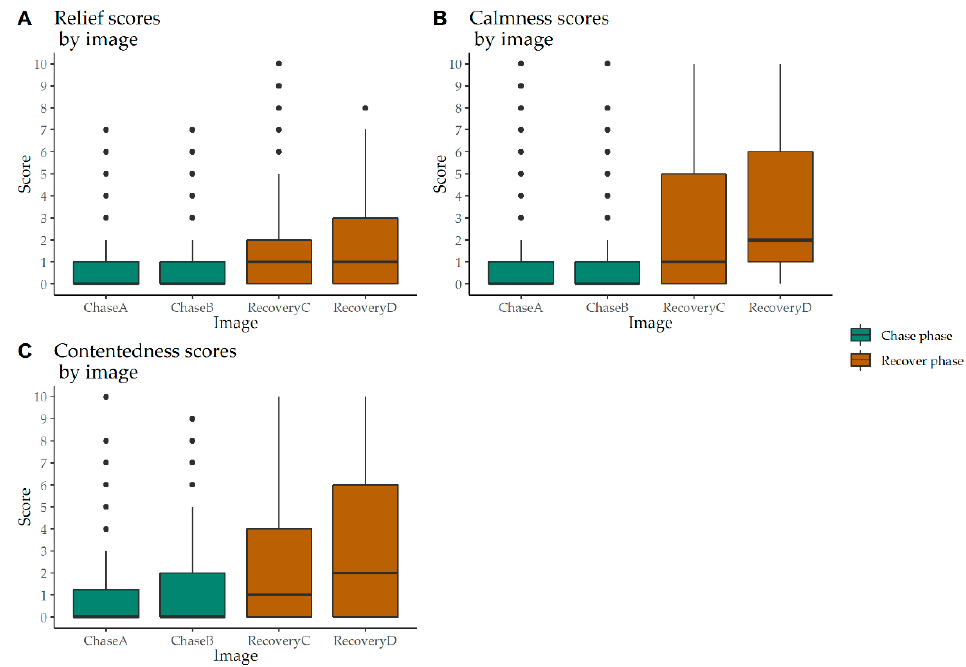
Figure 5. Box and whisker plot of relieved, calm and contented scores applied by a panel of 16 students on 80 images of calves ( n = 20) showing higher scores in the recovery phase compared to the chase phase of a calf roping event. Outliers were present mostly in the chase phase.